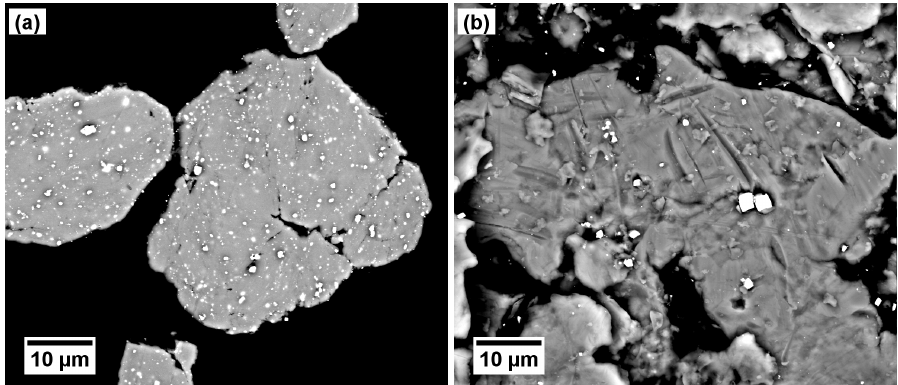
Figure 6. WC-Co seen as bright spots (back-scattered electron contrast): ( a ) inside Ti particles; ( b ) on the particle